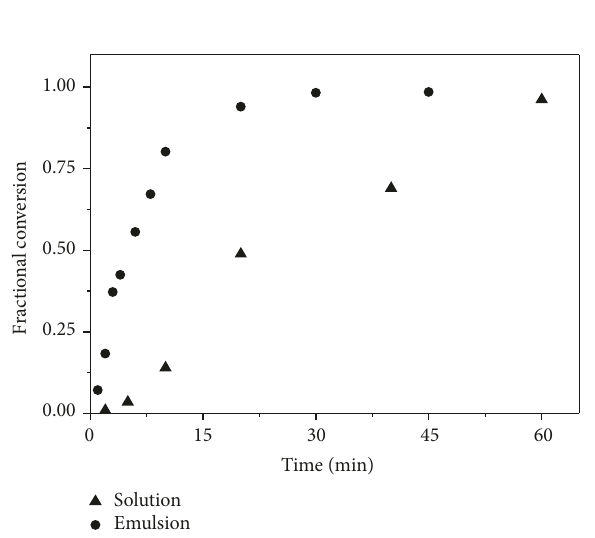
Figure 2: Evolution of fractional conversion for the PAM synthe- sized by emulsion and solution